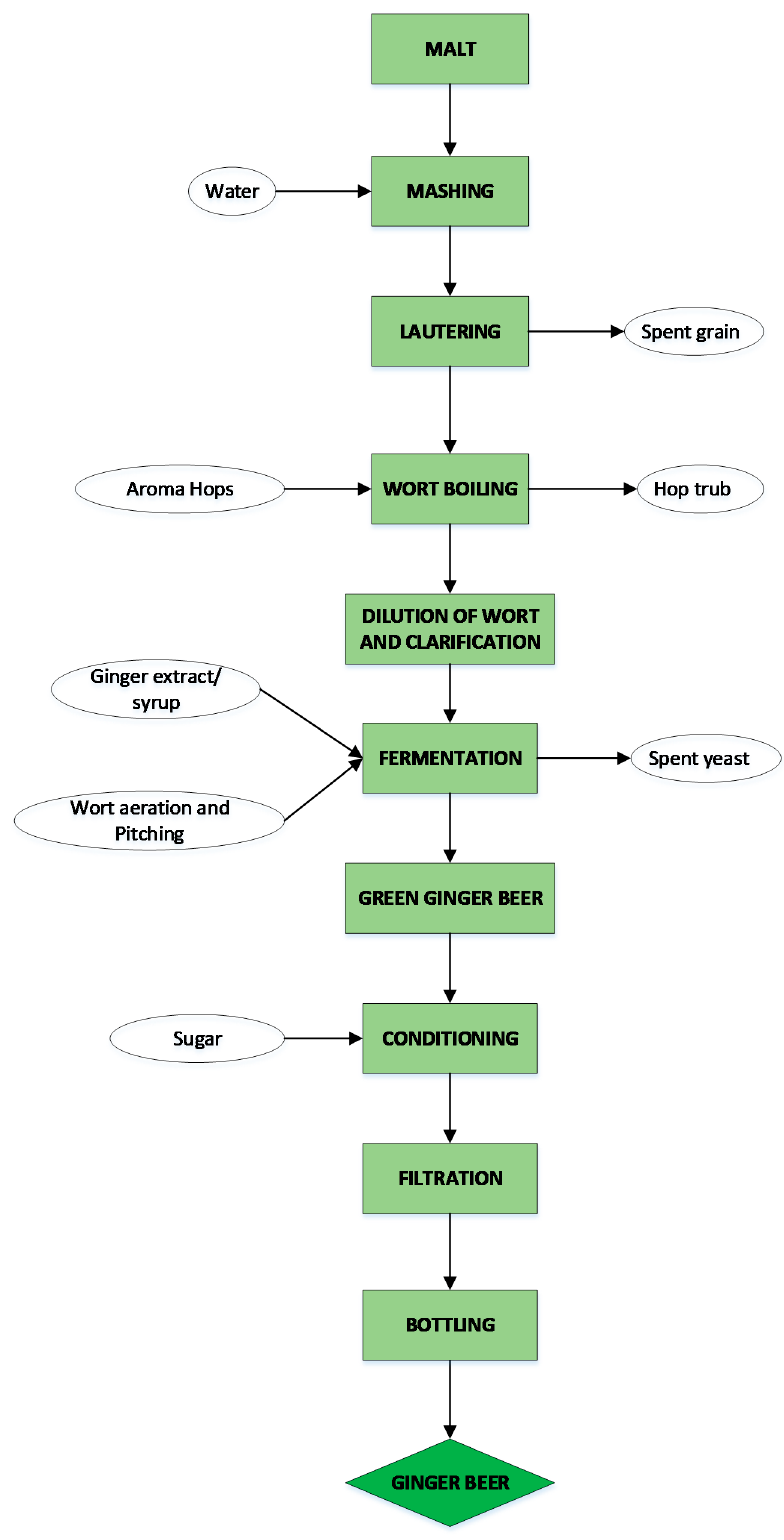
Figure 1. Production flow chart of ginger beer.